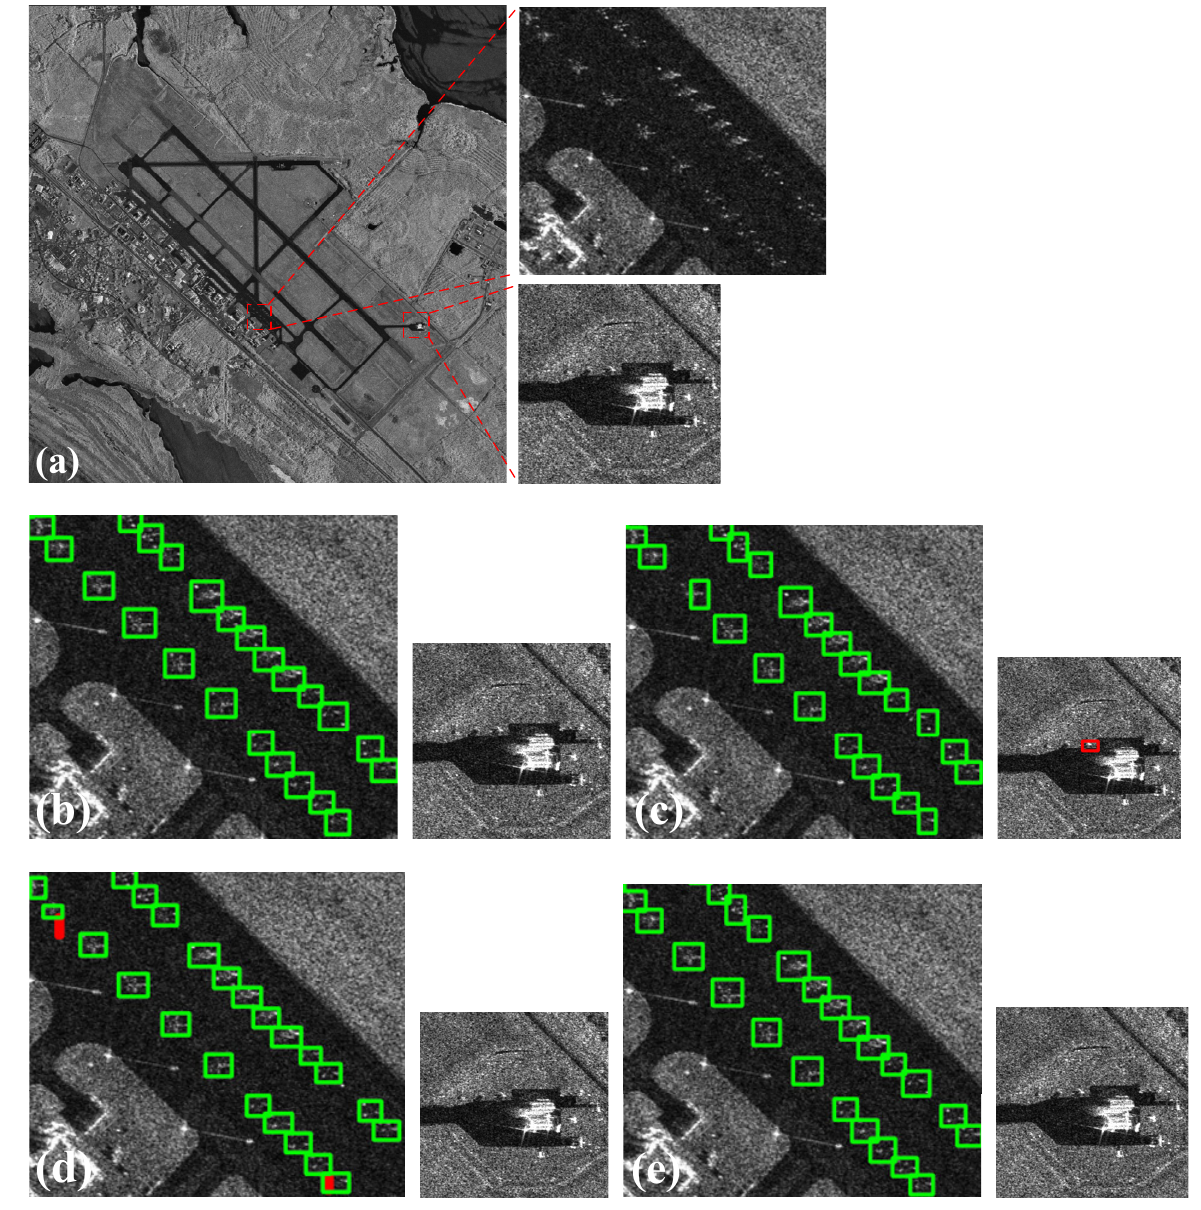
Figure 12. The experiment result for Airport I. ( a ) SAR image of Airport I from Gaofen-3. ( b ) The ground truth of the airport. ( c – e ) the aircraft detection results of ( a ) by EfficientDet, YOLOv4, and EWFAN. The green box, the red box and the yellow box represent the correctly detected aircrafts, the false alarms, and the missed alarms respectively.